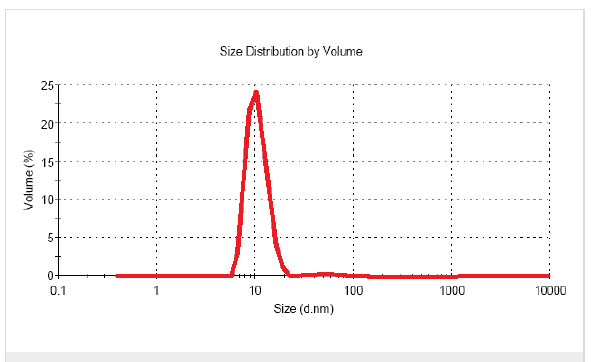
Figure 4: Size distribution of the zinc oxide particles produced in the sonoplasma discharge.